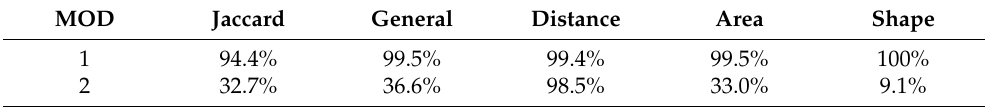
Figure 9. Results of Vehicle Detection. To properly evaluate detection of the most crucial segment for this function, the algorithm considers different detection centers that relocate depending on the type of the object and size of the GT bounding box data. Table 2. The rectangular similarity and the Jaccard index for moving objects detected in Figure